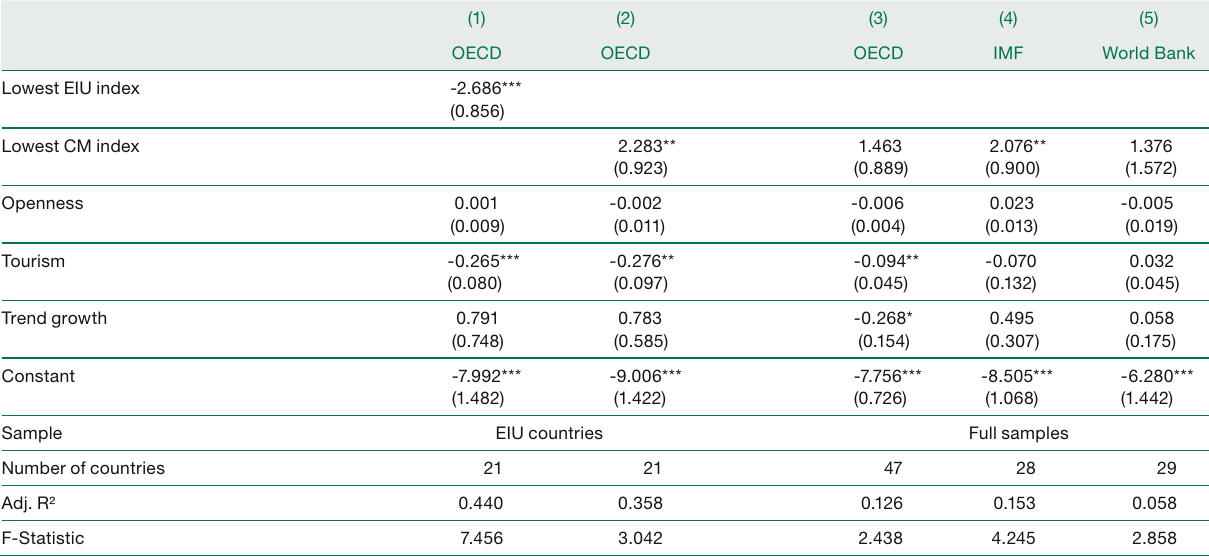
GDP growth revisions and the quality of government response in the fourth quartile